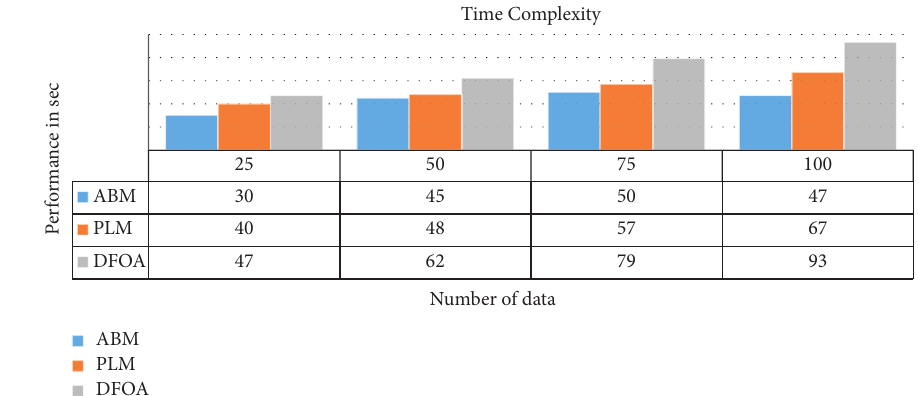
Figure 6: The analysis of time